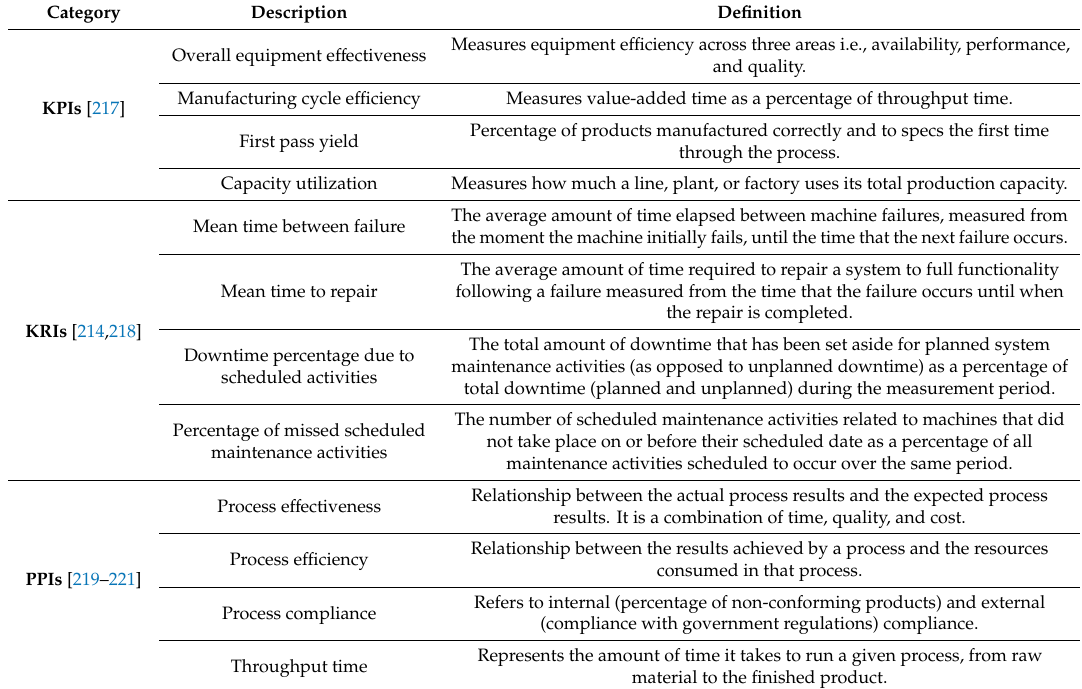
Table 2. Examples of key performance indicators (KPIs), key risk indicators (KRIs), and process performance indicators